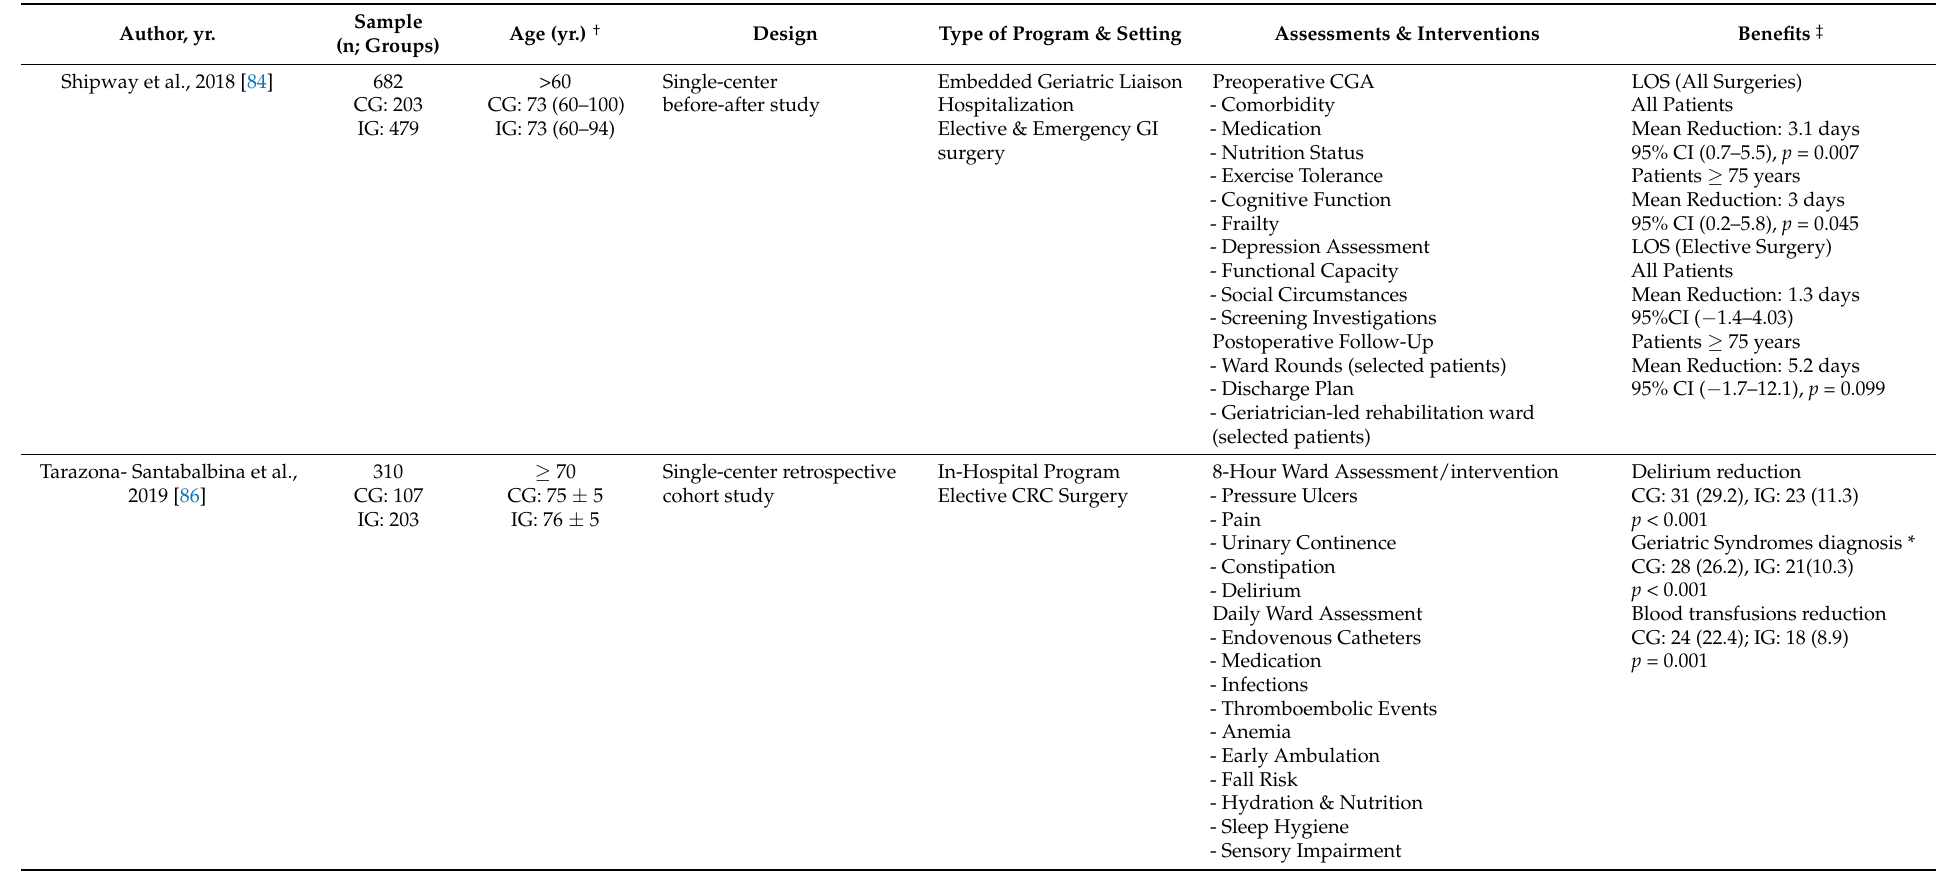
Table 2. Summary of studies assessing the benefits of a geriatric liaison on the approach of colorectal cancer patients undergoing surgery. Author,